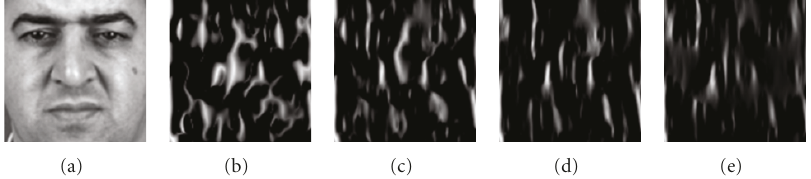
Figure 6: Examples of OGPCIs (from left to right): (a) the original face image, (b) the OGPCI for p = 2, (c) the OGPCI for p = 3, (d) and the OGPCI for p = 4, (e) the OGPCI for p =